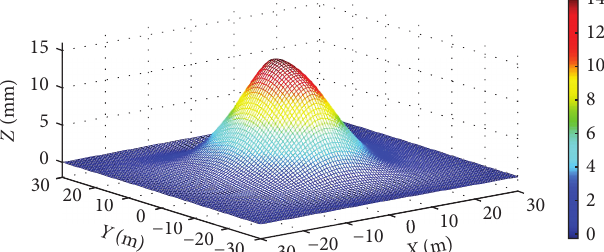
Figure 19: Heaving displacement of ground frost heave caused by freezing for 90 days (mm, α � 10 °